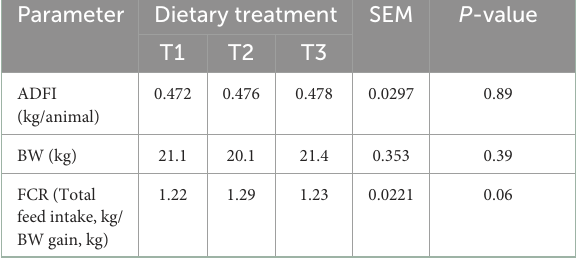
TABLE 3 The effect of dietary treatment on ADFI (average daily feed intake), BW (body weight), and feed conversion ratio (FCR). Parameter